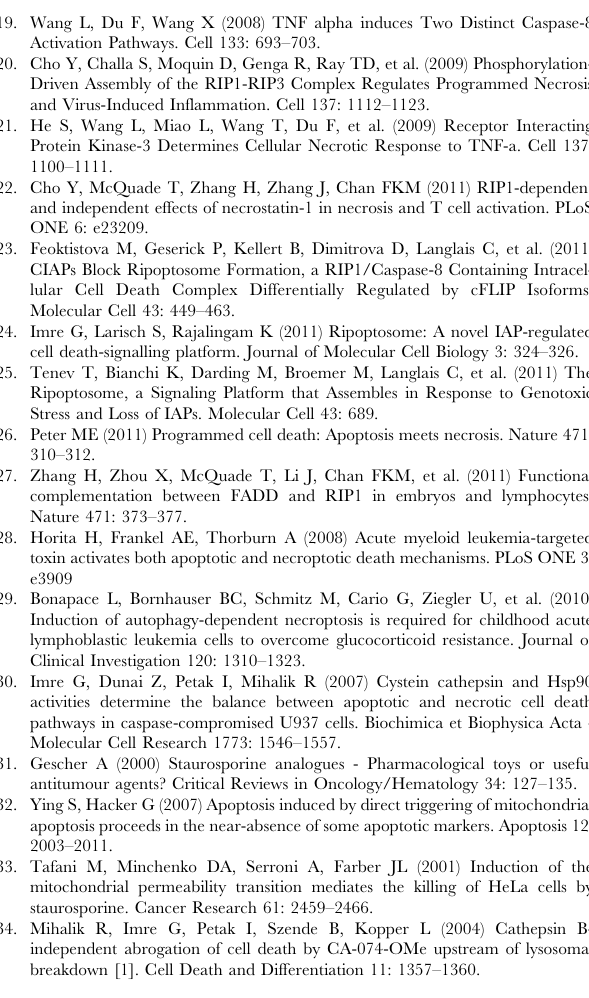
with samples treated as indicated for 20 hrs (representative of the panel. (I) zVD treatment prevents RIPK1 fragmentation triggered by STS. Western blot analysis was performed for the detection of RIPK1 protein level and presence of cleaved fragment due to caspase activity (representative of n= 2). Figure S5 PJ-34 does not arrest the TRAIL-induced necroptosis in the presence of caspase inhibitor. U937 cells were treated with TRAIL (50 ng/mL) in the presence or absence of zVD (5 m M) for 20 hrs. PJ-34 (1 m M) was added 1 hr before cell death induction. (A) Column diagram of percentage of cells with high DiOC 6 (3) fluorescence intensity (n= 4). (B) Column diagram of percentage of cells with high AO red fluorescence intensity (n= 2). (C) Representative histograms of PI stained, ethanol-fixed cells detected by flow cytometry (sub-G1 technique). The numbers indicate the percentage of cells in the marked regions (n =8). Text S1 GA is more potent inhibitor than Nec during STS-provoked